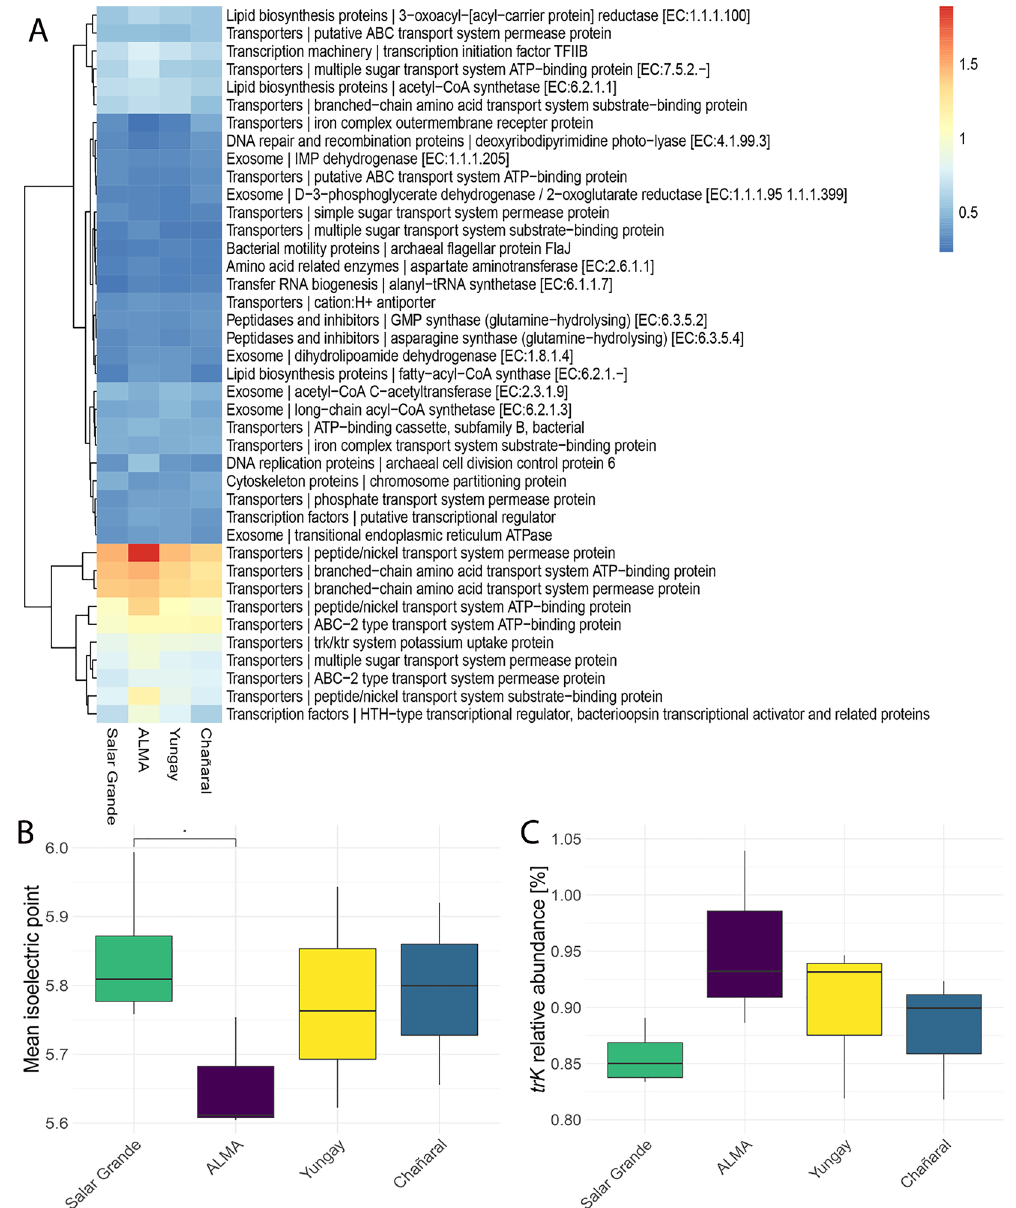
Figure 4. Functional changes across sites 1 year after transplantation of halite nodules represented by ( A ) relative abundances of the 40 most abundant KEGG Brite pathways in all contigs; color-coded legend is in %. ( B ) Weighted average of predicted protein isoelectric points of proteins encoded in all contigs. ( C ) Potential potassium uptake inferred from tr K genes relative abundance quantified in all